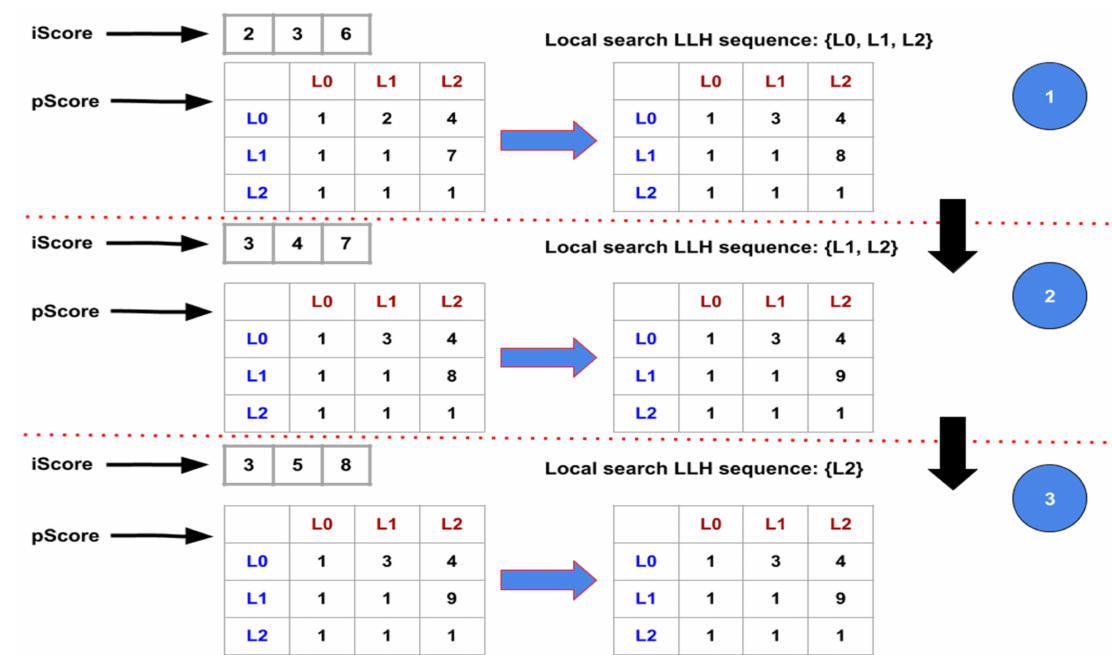
Figure 2. Illustration of LS-Seq update